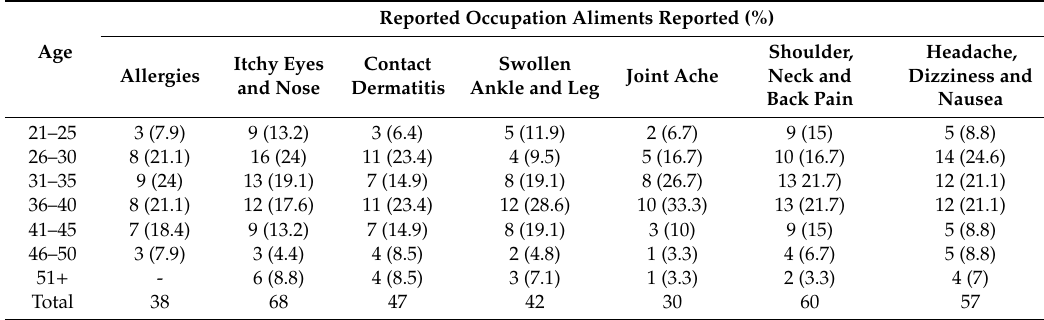
Table 3. Occupational ailments prevalence reported based on age distribution among the study